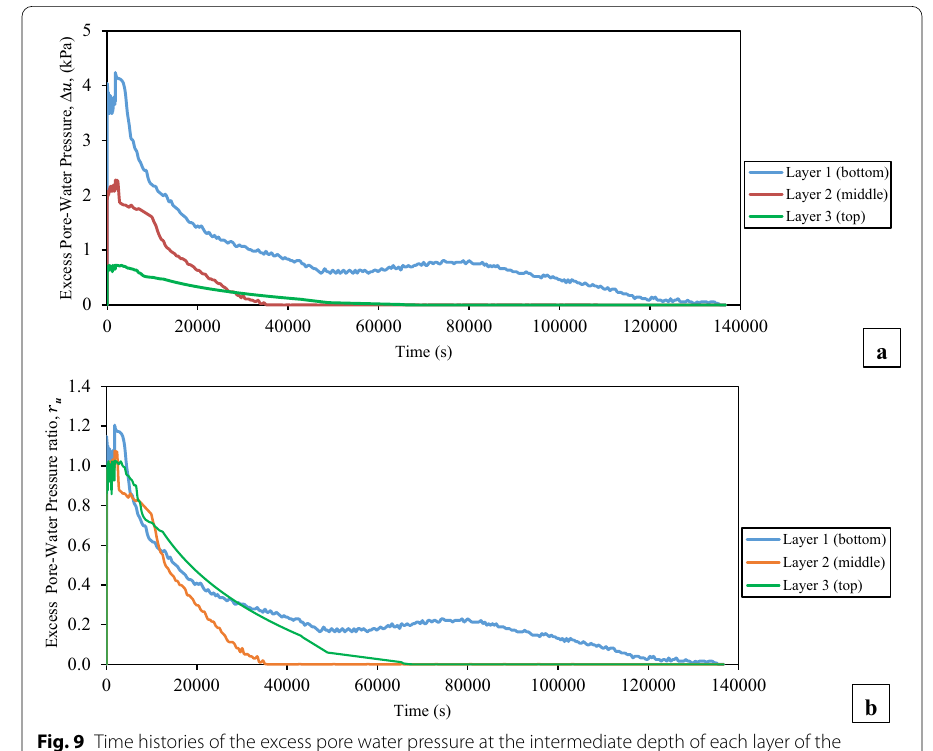
Fig. 9 Time histories of the excess pore water pressure at the intermediate depth of each layer of the thickened tailings deposit during and after shaking loading. a Measured excess pore water pressures (∆ u ). b Excess pore water pressure ratios ( r u )